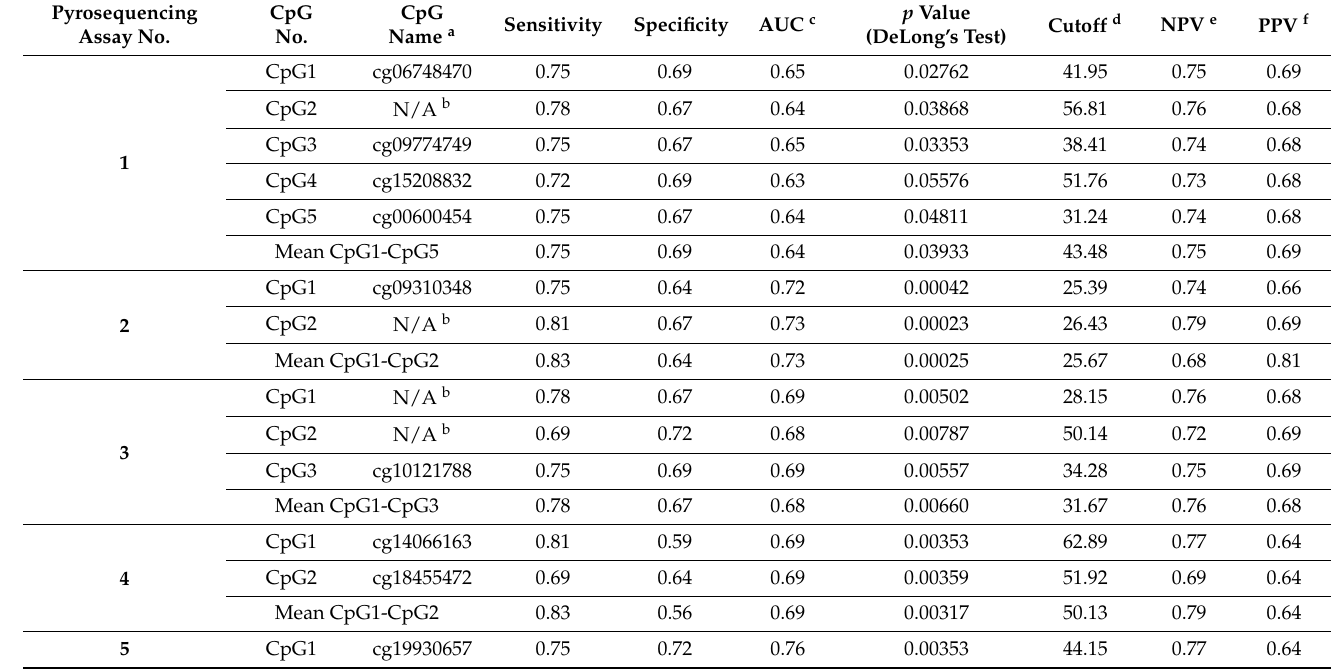
Table 2. Individual CpG and assay performance based on ROC curves. Pyrosequencing Assay No.